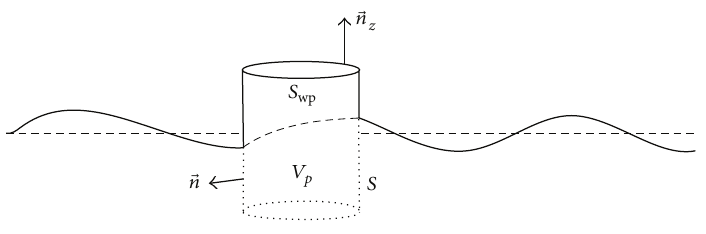
Figure 2: Heaving buoy in waves.